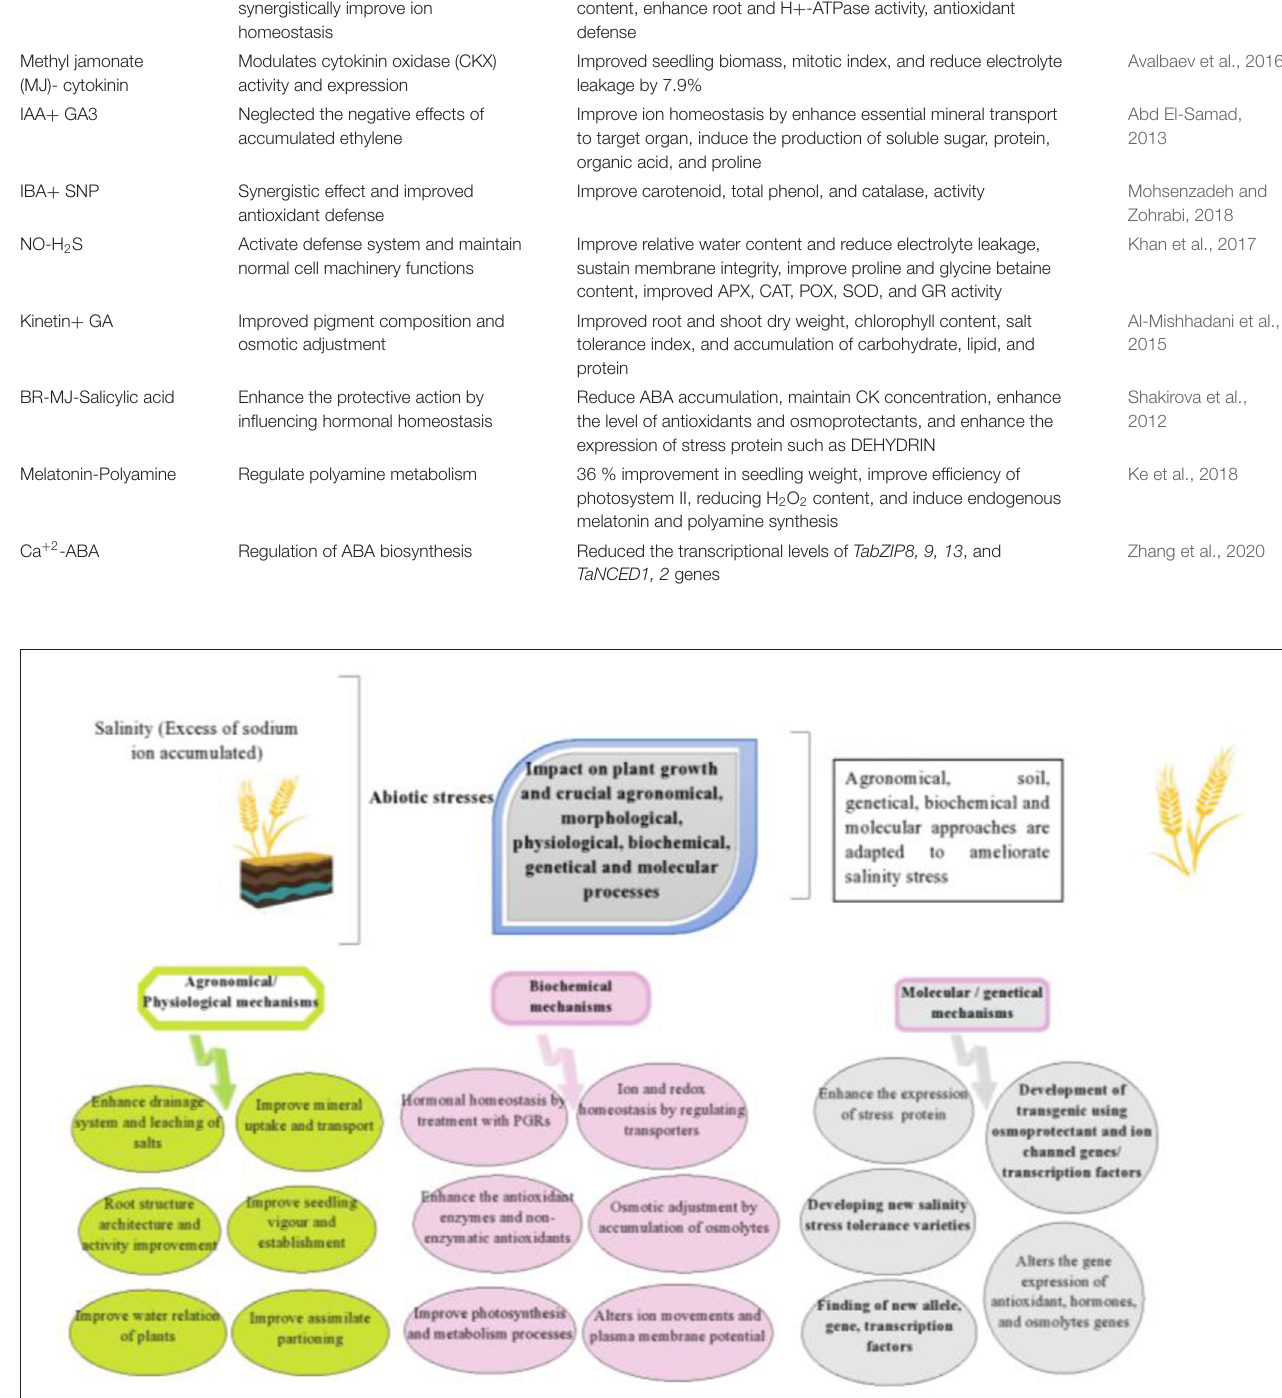
Frontiers in Agronomy |